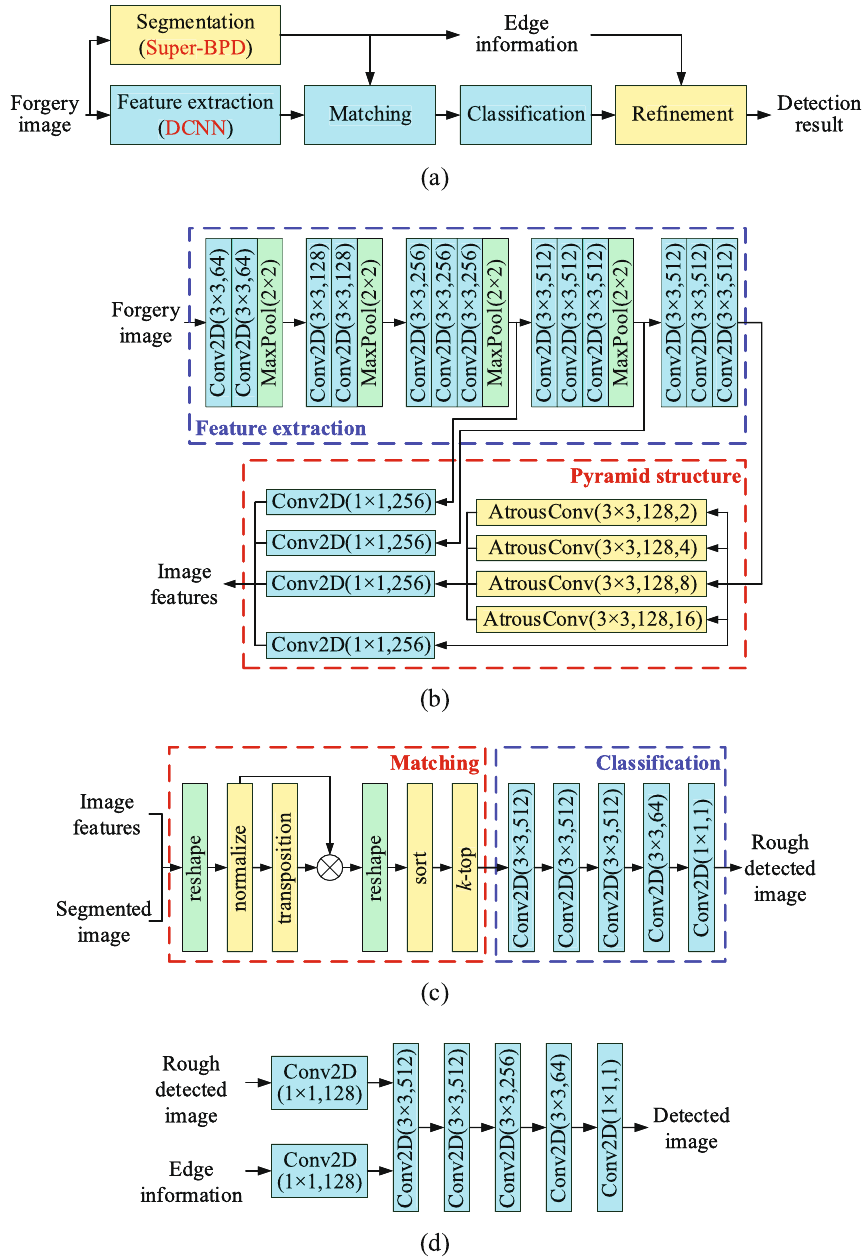
Figure 1. Framework of the SD-Net: ( a ) overview, ( b ) feature extraction module, ( c ) matching and classification modules, and ( d ) refinement